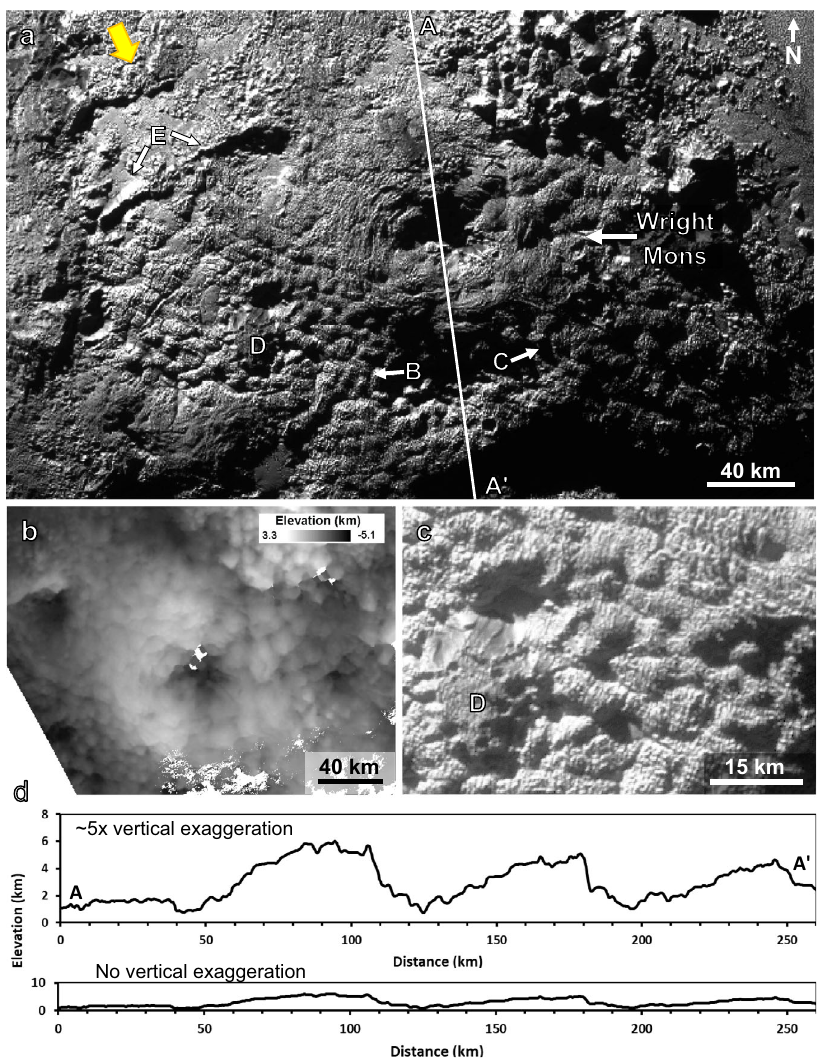
Fig. 1 Features of Wright Mons and the surrounding terrain. a Wright Mons region with features labelled (see text), b , high-resolution topography for Wright Mons 36 , c , zoom of region with smaller dome named Coleman Mons (label “ D ” ; also see Fig. 4), undulating, hummocky terrain on the fl anks of Wright Mons and the superposed smaller-scale (1 – 2 km) ridges or boulders, d , topographic pro fi le of Wright Mons and adjacent rise as shown by the line A to A ’ in panel a. All images are from the new Horizons observation PEMV_P_MVIC_LORRI_CA (315 m px − 1 ; see Supplementary Table 1) on a simple cylindrical projection. The large arrow in the upper left of panel a indicates the direction of incoming sunlight and is repeated in subsequent fi gures. All fi gures in the main text and supplement are shown with north up. The longitude and latitude extents of the image are as follows: panel a ~163 – 182°E and ~16 – 28°S; panel b ~166 – 177°E and ~17 – 24°S; panel c ~167 – 171°E and ~22 –